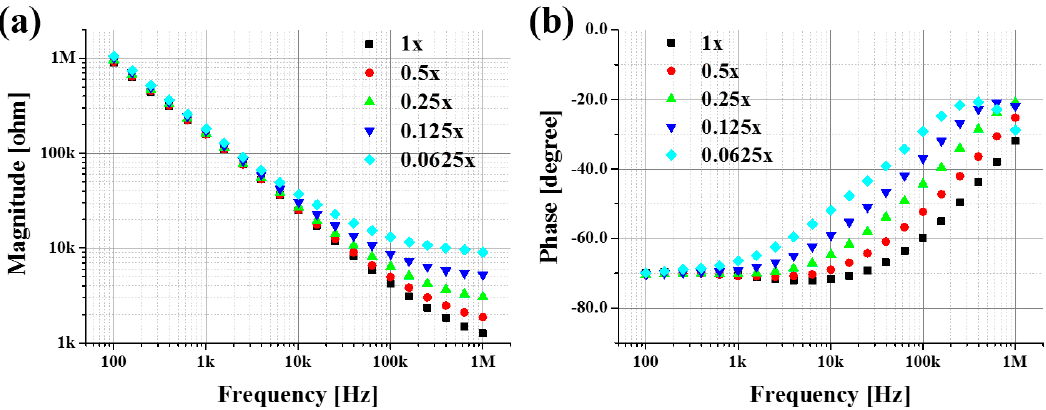
Figure 3. Averaged electrical impedances of PBS at various concentration levels: ( a ) magnitude and ( b ) phase.